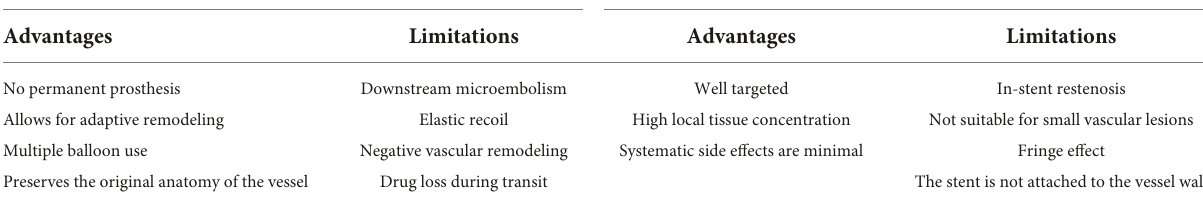
TABLE 1 Characteristics comparison between DCB and